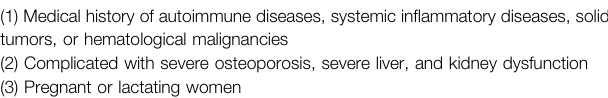
TABLE 4 | Exclusion criteria of the normal